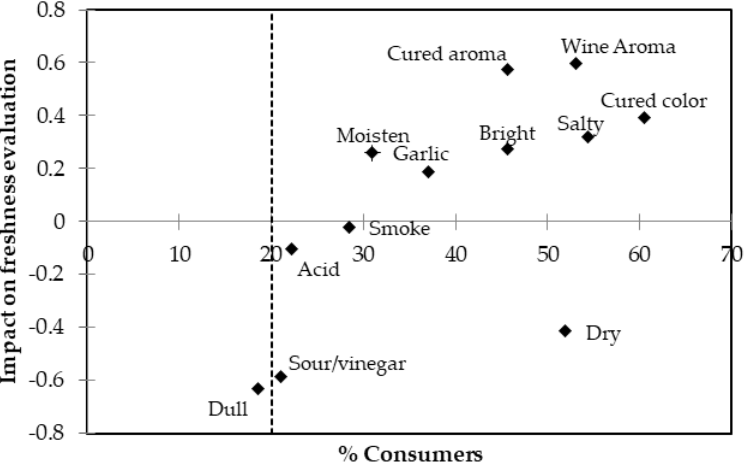
Figure 4. Mean impact on the freshness evaluation of the attributes checked by the participants at 126 days of storage. The dashed vertical line defines 20% of